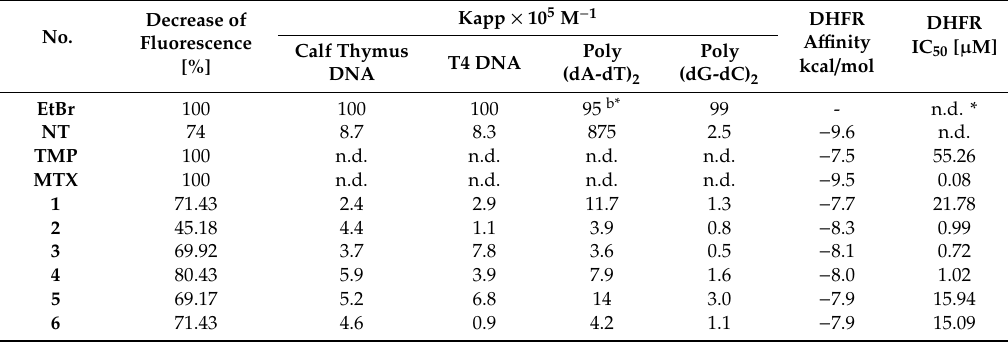
Table 1. DNA-binding effects, association constants (Kapp), dihydrofolate reductase (DHFR)